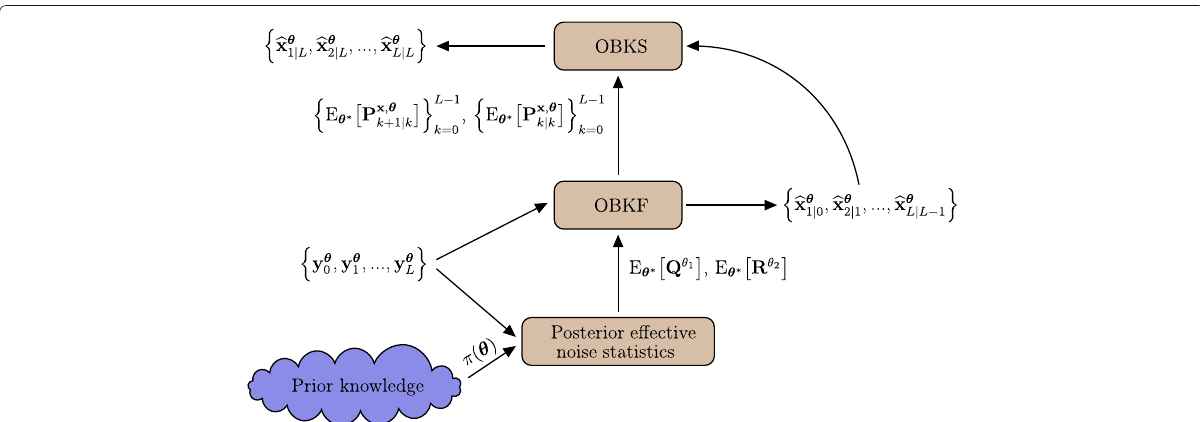
Fig. 1 Illustrative view of the proposed OBKS framework. This figure presents the general framework of the proposed optimal Bayesian Kalman smoothing framework. The posterior effective noise statistics are obtained by integrating the data in the observations window into the prior distribution π( θ ) , which are used to run the OBKF in the forward direction. Then, the Bayesian smoothed estimates are obtained in the backward direction as the outputs of the OBKS the by-products of the OBKF in the forward direction. Also, all computational steps for the OBKS are sum- marized in Algorithm 1. The inputs are the prior dis- tribution, the matrices that characterize the state-space model, and the observations over the observation window.